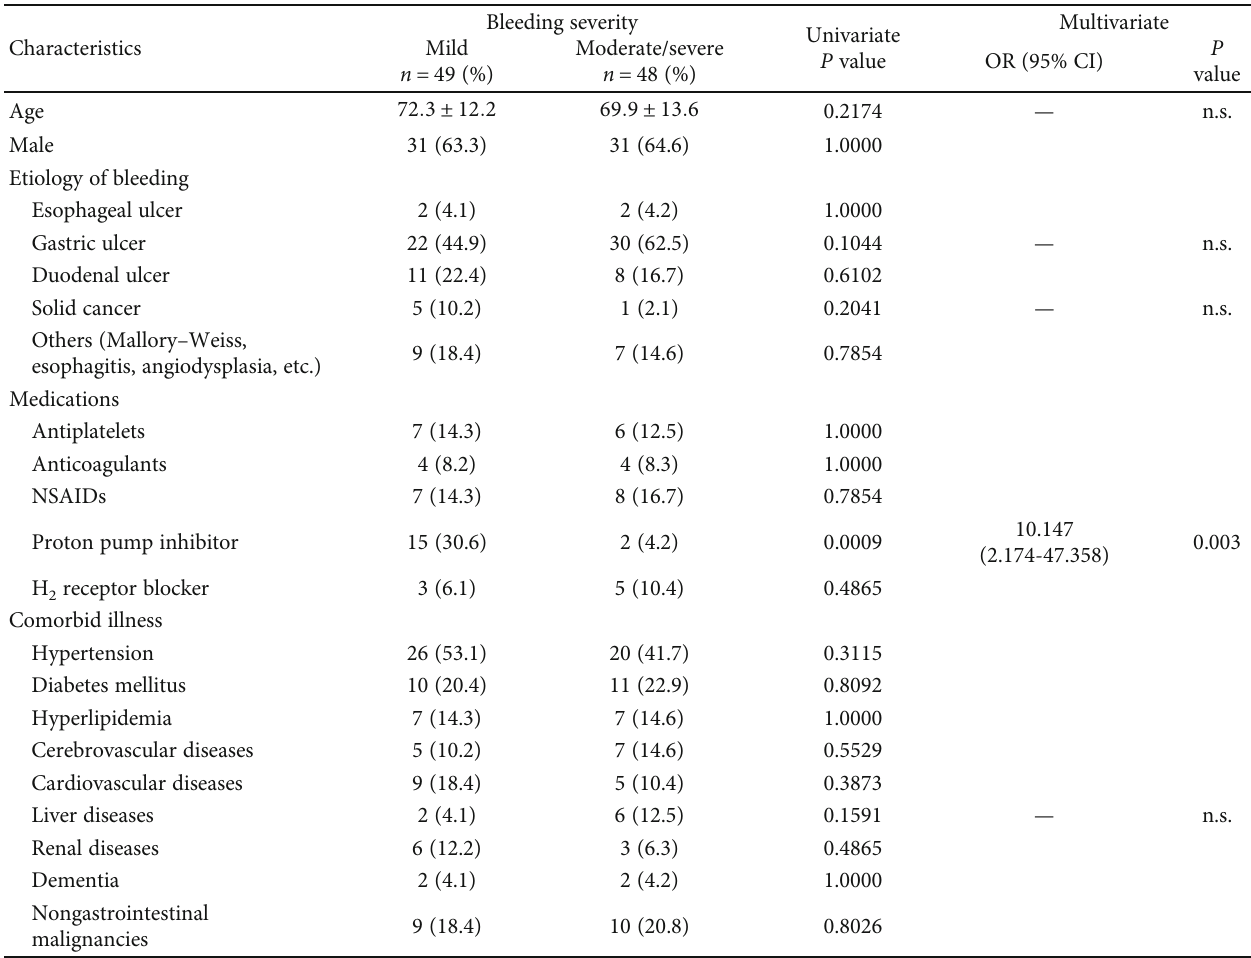
Table 1: Comparison of the clinical characteristics between the two groups of patients with di ff erent severities of upper gastrointestinal